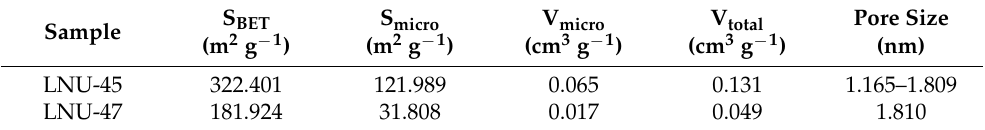
Figure 2. N 2 adsorption–desorption isotherms ( a ) and pore size distribution ( b ) of LNU-45 and LNU-47. Table 1. Porosity data for LNU-45 and LNU-47.